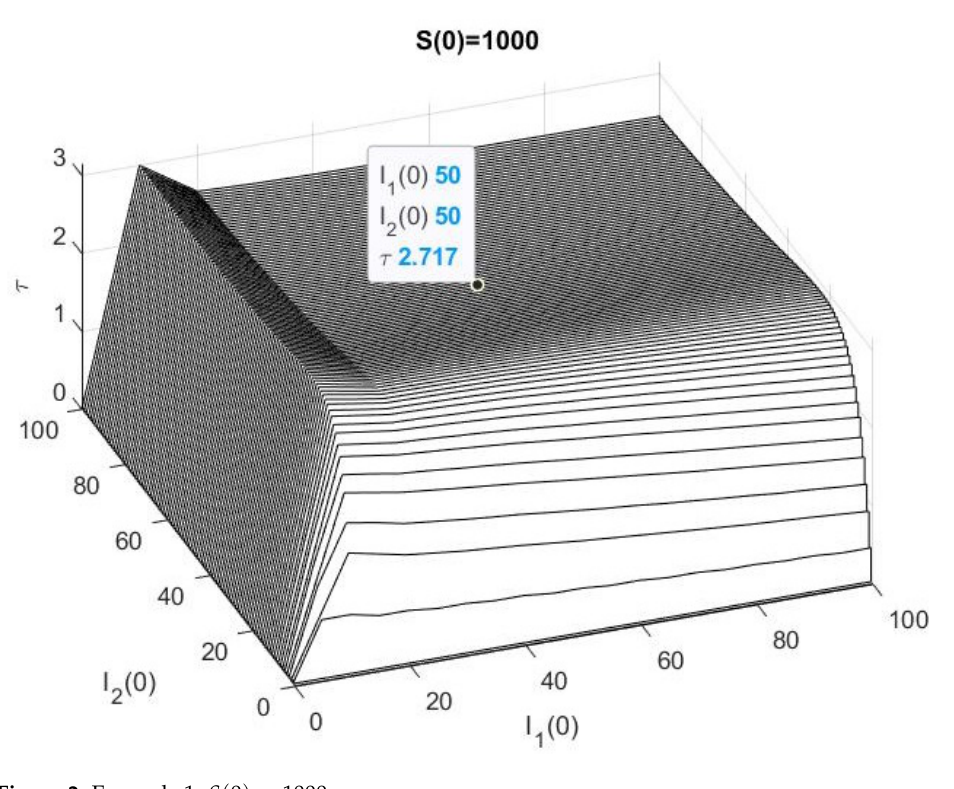
Figure 2. Example 1: S ( 0 ) = 1000 . Table 3. Example 1: Euler–Maruyama